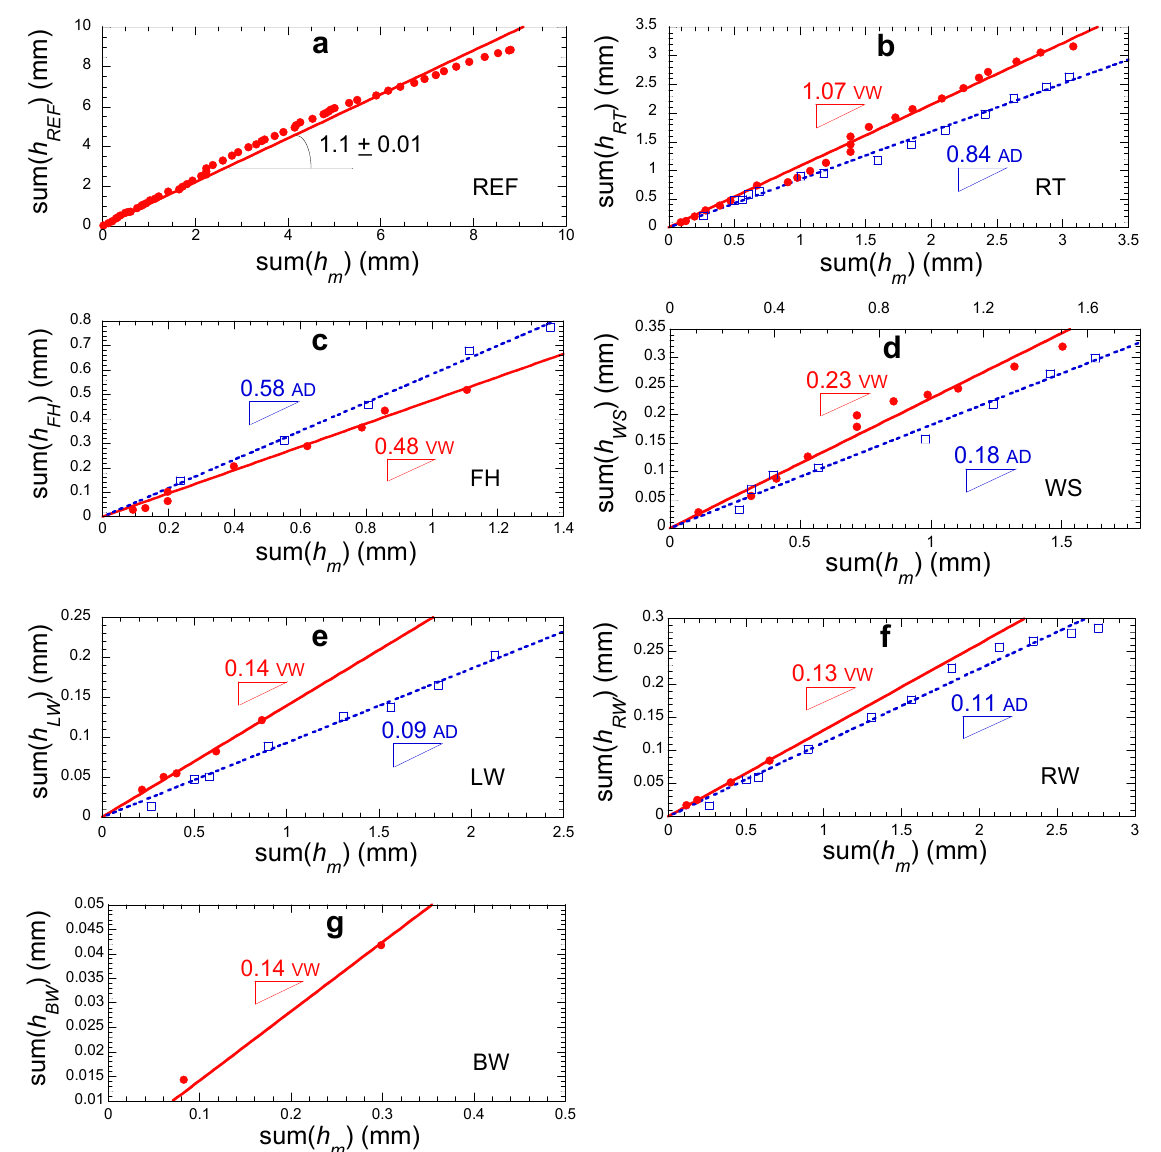
Figure 17. Comparison between the calculated sum of dew yields from meteo data (sum( h m )) and experimental values ( a ) from the reference surface (sum( h REF )) and the VW and AD car surfaces: ( b ) RT, ( c ) FH, ( d ) WS, ( e ) LW, ( f ) RW, and ( g ) BW. The data are fitted to sum( h j ) = λ j sum( h m ). The λ j values are noted in the figures. Standard deviations are ≈ 0.01. Red dots: VW car; blue open squares: AD car.